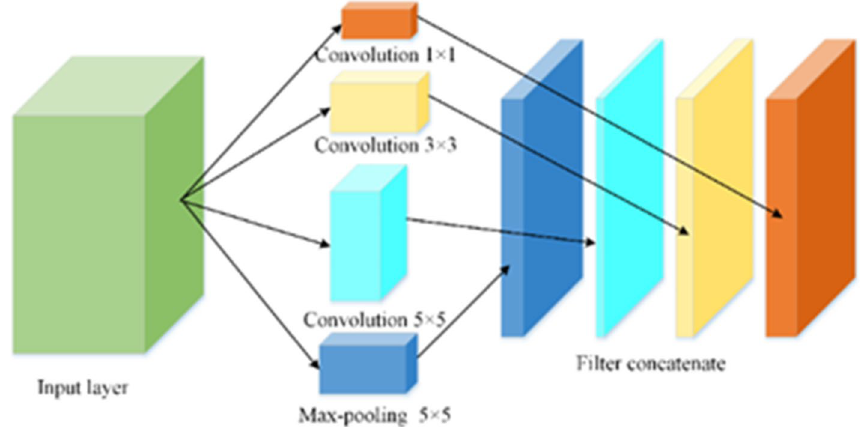
Figure 5. Diagram of internal structure of inception module.